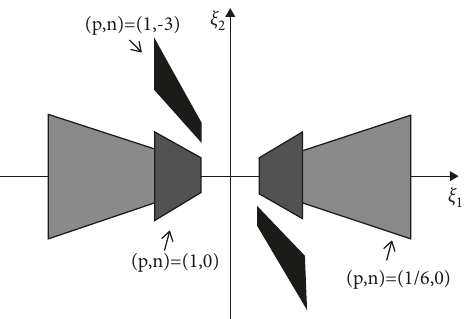
Figure 1: The support in the frequency domain of Shearlets with different p and